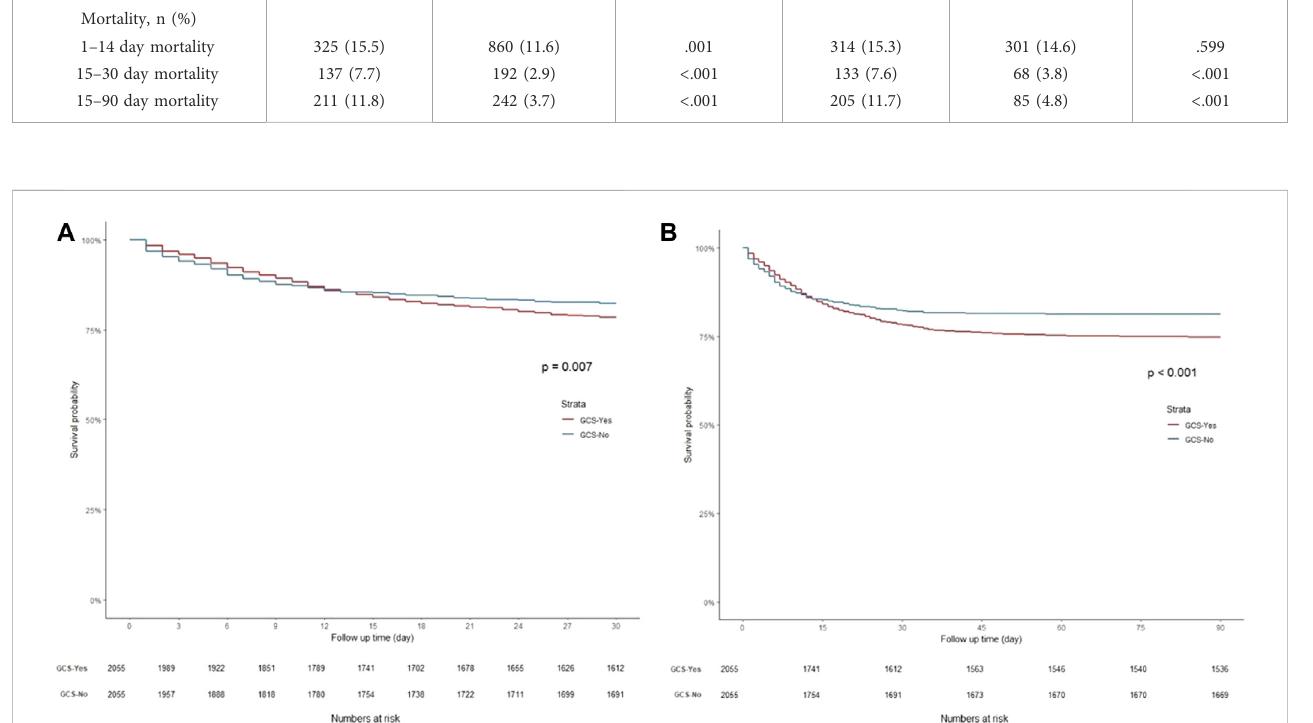
TABLE 2 Mortality rates in patients with heart failure in the glucocorticoids group and non-glucocorticoids groups. Before PSM After PSM GCS Non-GCS p -value GCS Non-GCS p -value Mortality, n (%)